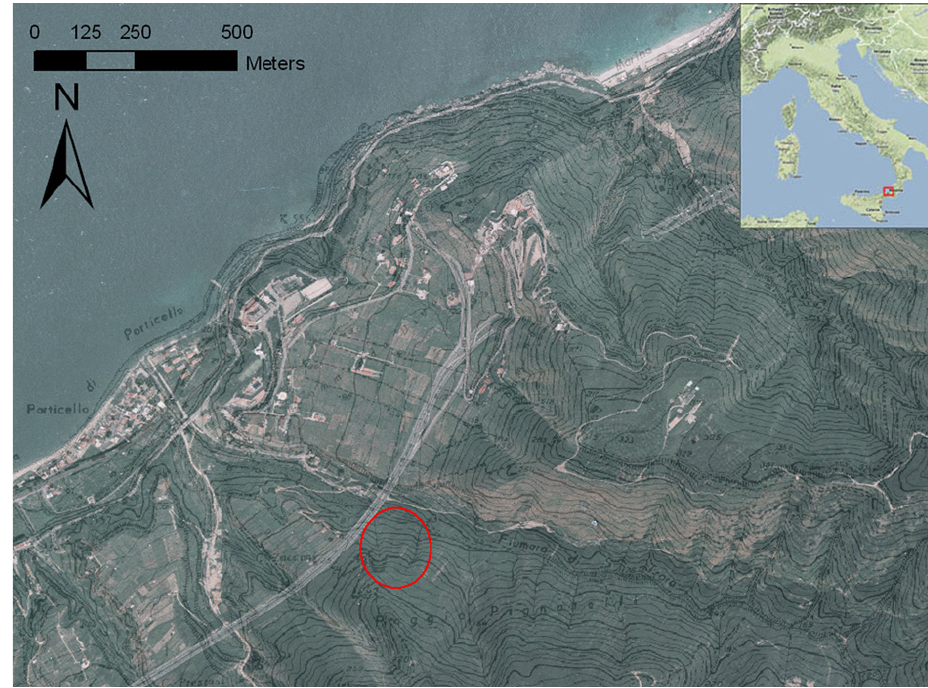
Fig. 1. Geographical setting of Santa Trada landslide (Volo Italia,